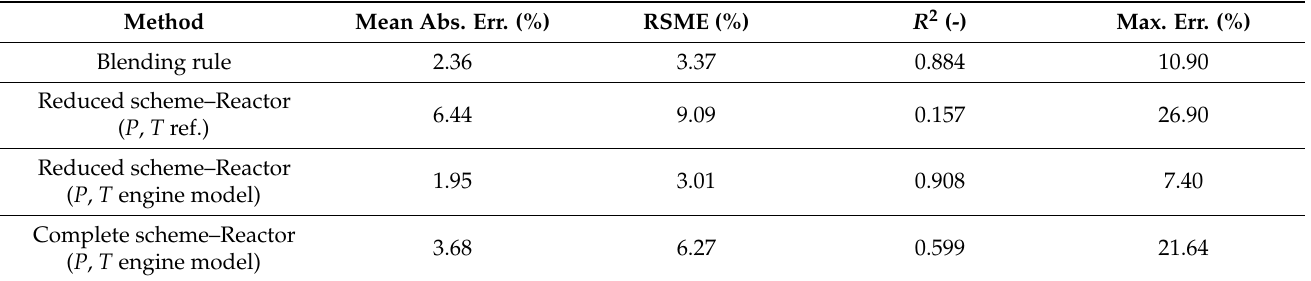
Figure 7. Correlation between calculated CR at knock conditions and experimental RON for PRFs and the 19 test surrogates performed with the complete (points) and reduced (stars) kinetics schemes. P , T input from engine model; method: Cantera reactor simulation. Table 4. Palette of the chemical species chosen for chemical kinetics simulations and their